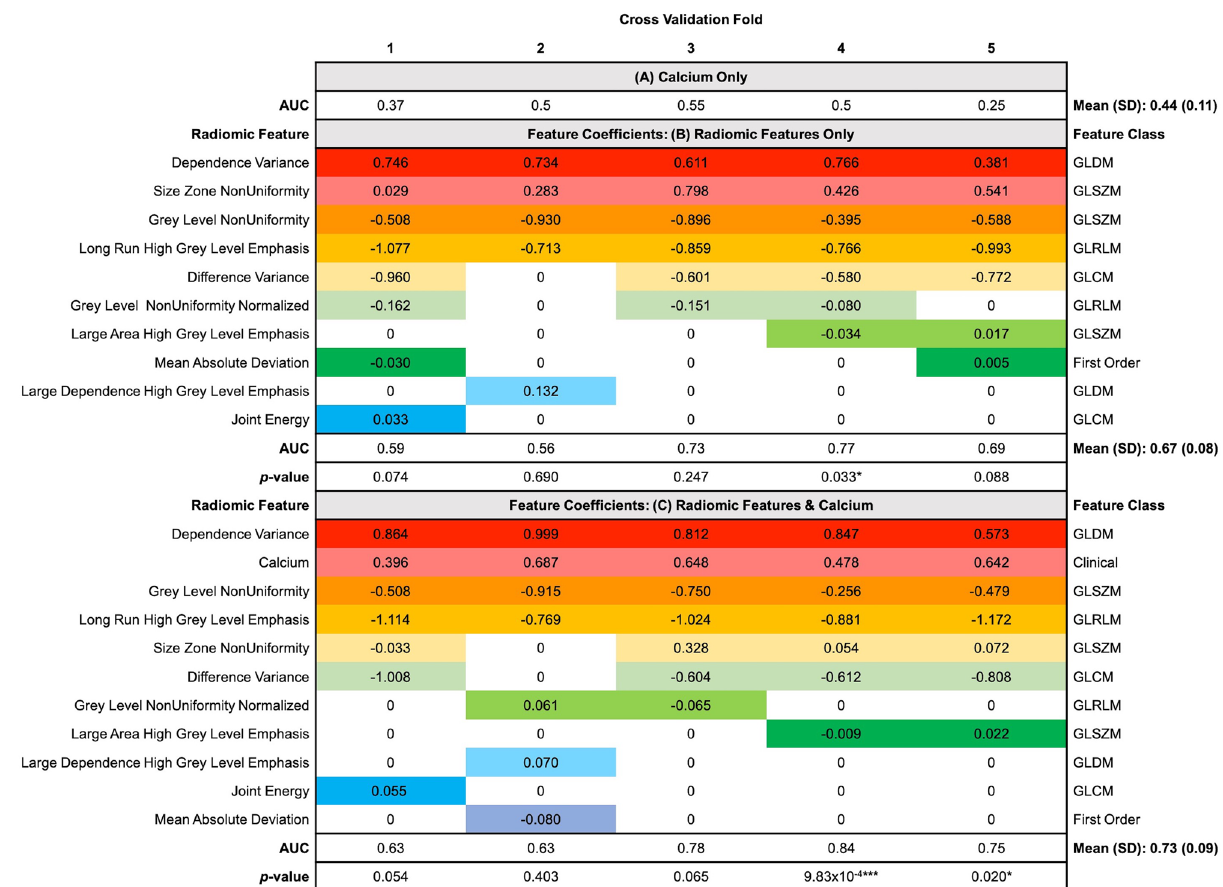
Figure 4. AUC and feature coefficients of predictors used in the Elastic Net logistic regression classifier in multi-slice analysis with resegmentation. The coefficients of the non-redundant radiomic features with excellent robustness in multi-slice analysis with resegmentation according to the Elastic Net model per fold of the five-fold cross-validation scheme are provided. The name of these radiomic features are provided on the left-hand side, whilst their corresponding feature classes are given on the right-hand side of the table. The AUC for each fold of cross-validation is provided and the mean AUC and standard deviation are stated in bold. The predictive performance of ( A ) when calcium is used as the only predictor, ( B ) when only radiomic features are the predictors, and ( C ) when using both radiomic features and calcium in an integrated model are provided. * p-value < 0.05, *** p-value < 0.001 when comparing the classification performance per fold of radiomic models B and C with the calcium only model ( A ) using DeLong’s method. The colours highlight non-zero feature coefficients where non-zero coefficients indicate how features played a role in the model’s